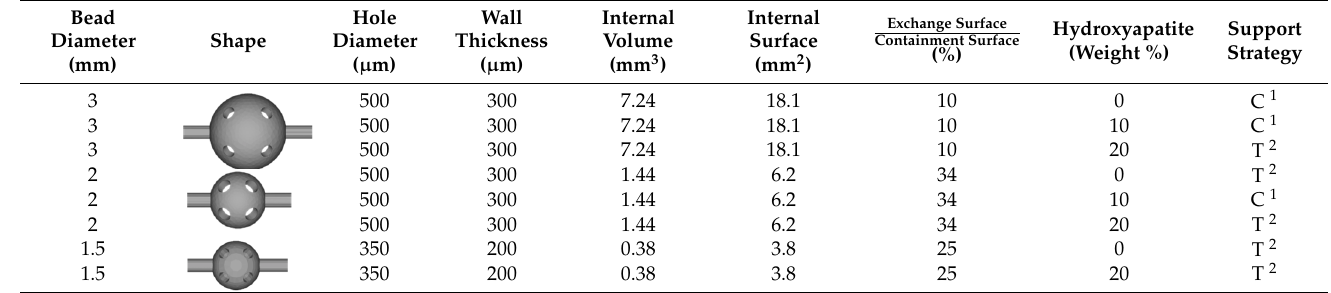
Figure 3. Vat photopolymerization: 3 mm beads built as a continuous chain and supported by a trabecular structure. Table 2. Geometrical characteristics of the beads produced by vat photopolymerization.